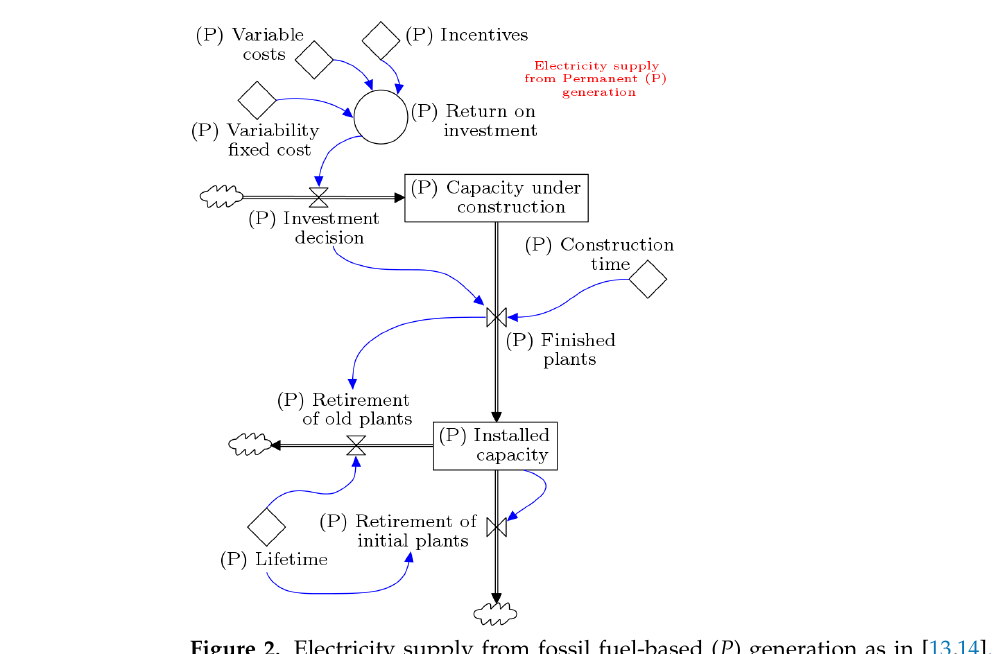
Figure 2. Electricity supply from fossil fuel-based ( P ) generation as in [13,14]. Variability fixed cost = fixed cost. Reprinted with the permission of Reference [13]. Copyright 2018 Elsevier.